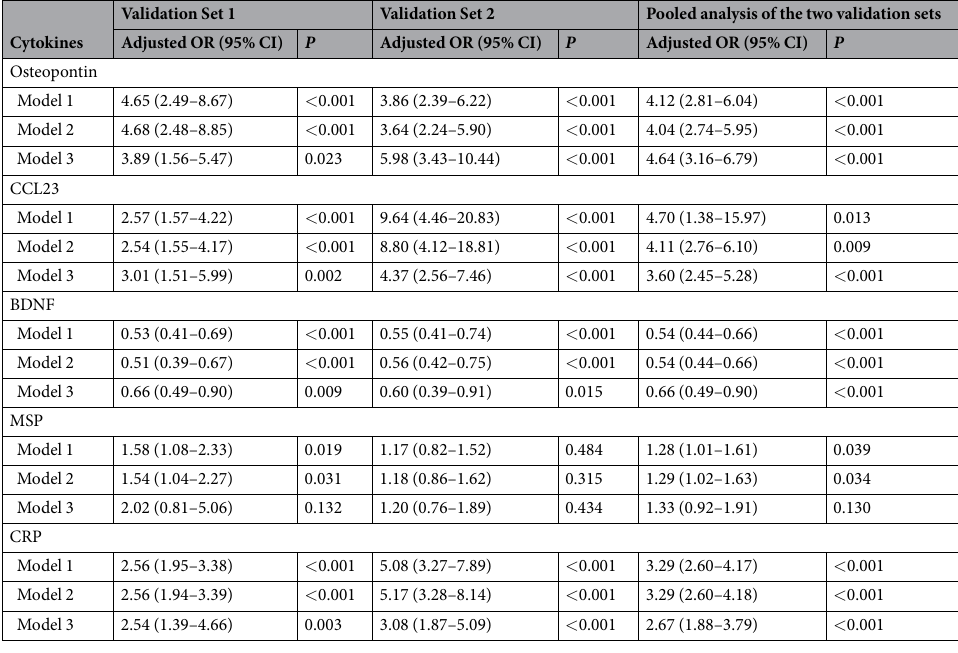
Table 2. Adjusted Odds Ratio for Risk of ACS According to Five Selected Plasma Cytokines in Two Case- control Validation Sets. Plasma cytokine levels were ln-transformed prior to analysis, and the ORs were shown as per SD increase of the ln-transformed value of each cytokines. Model 1: Adjusted for age (continuous). Model 2: Additionally, adjusted for BMI (continuous) and smoking status (current, former and never). Model 3: Additionally adjusted for total cholesterol (continuous), low-density lipoprotein cholesterol (continuous), triglycerides (continuous), fasting glucose (continuous), estimated glomerular filtration rate (continuous), systolic blood pressure (continuous), systolic blood pressure (continuous), anti-hypertensive medication (binary), and lipid-lowing medication